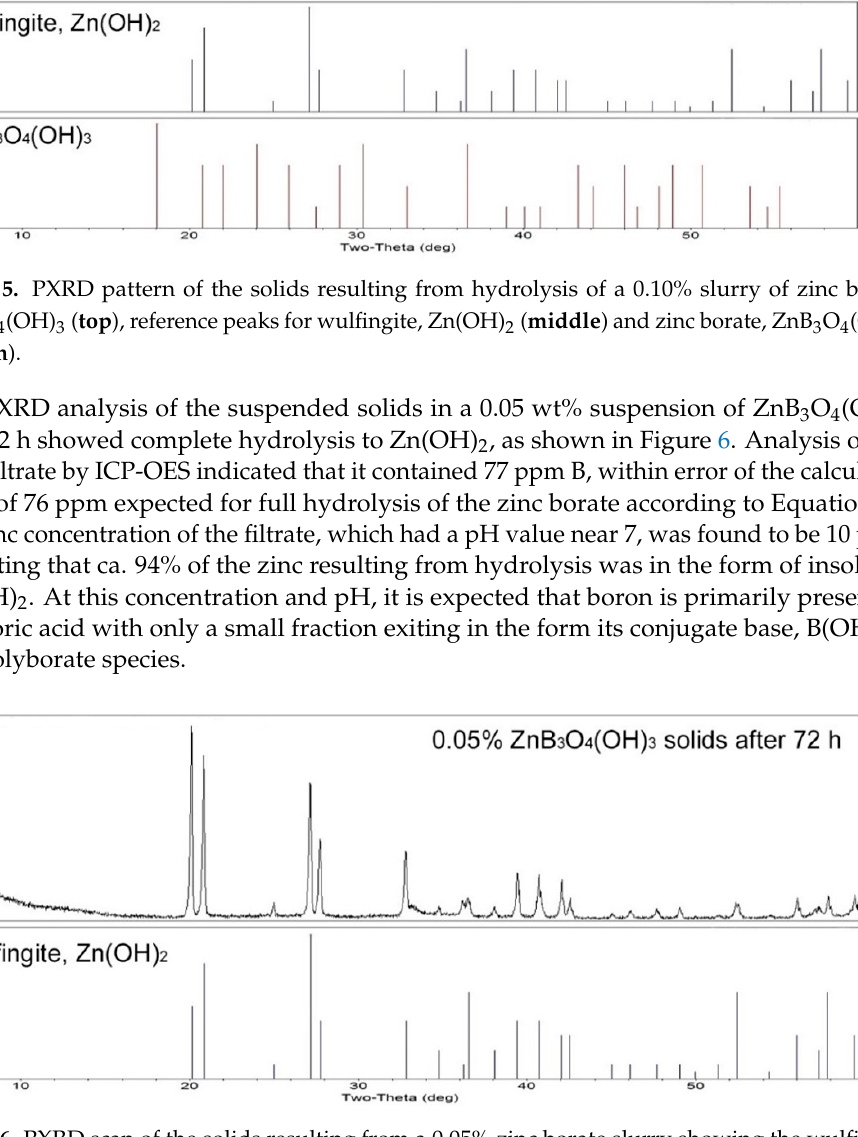
Figure 6. PXRD scan of the solids resulting from a 0.05% zinc borate slurry showing the wulfingite phase of Zn(OH) 2 as the sole hydrolysis product ( top ) and reference pattern for wulfingite ( bottom ).